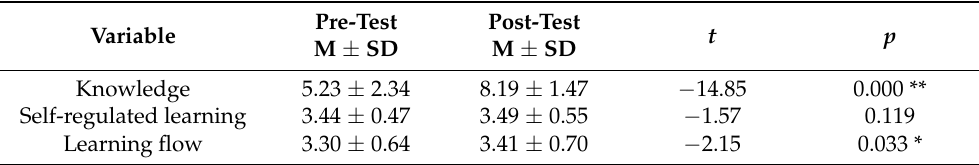
Table 3. Differences in Knowledge, Online Self-regulated Learning, and Learning Flow in Pre- and Post-tests ( N = 164).